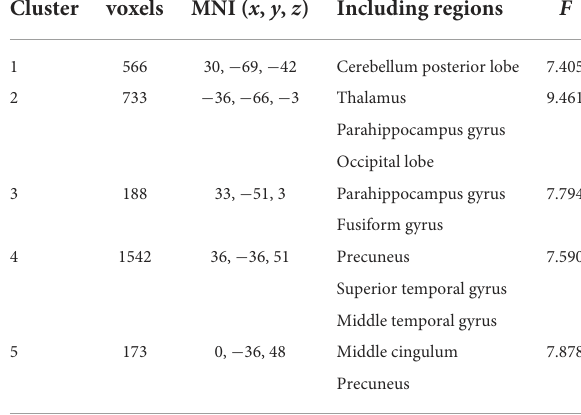
TABLE 3 Brain regions contributing to the observed global FCD